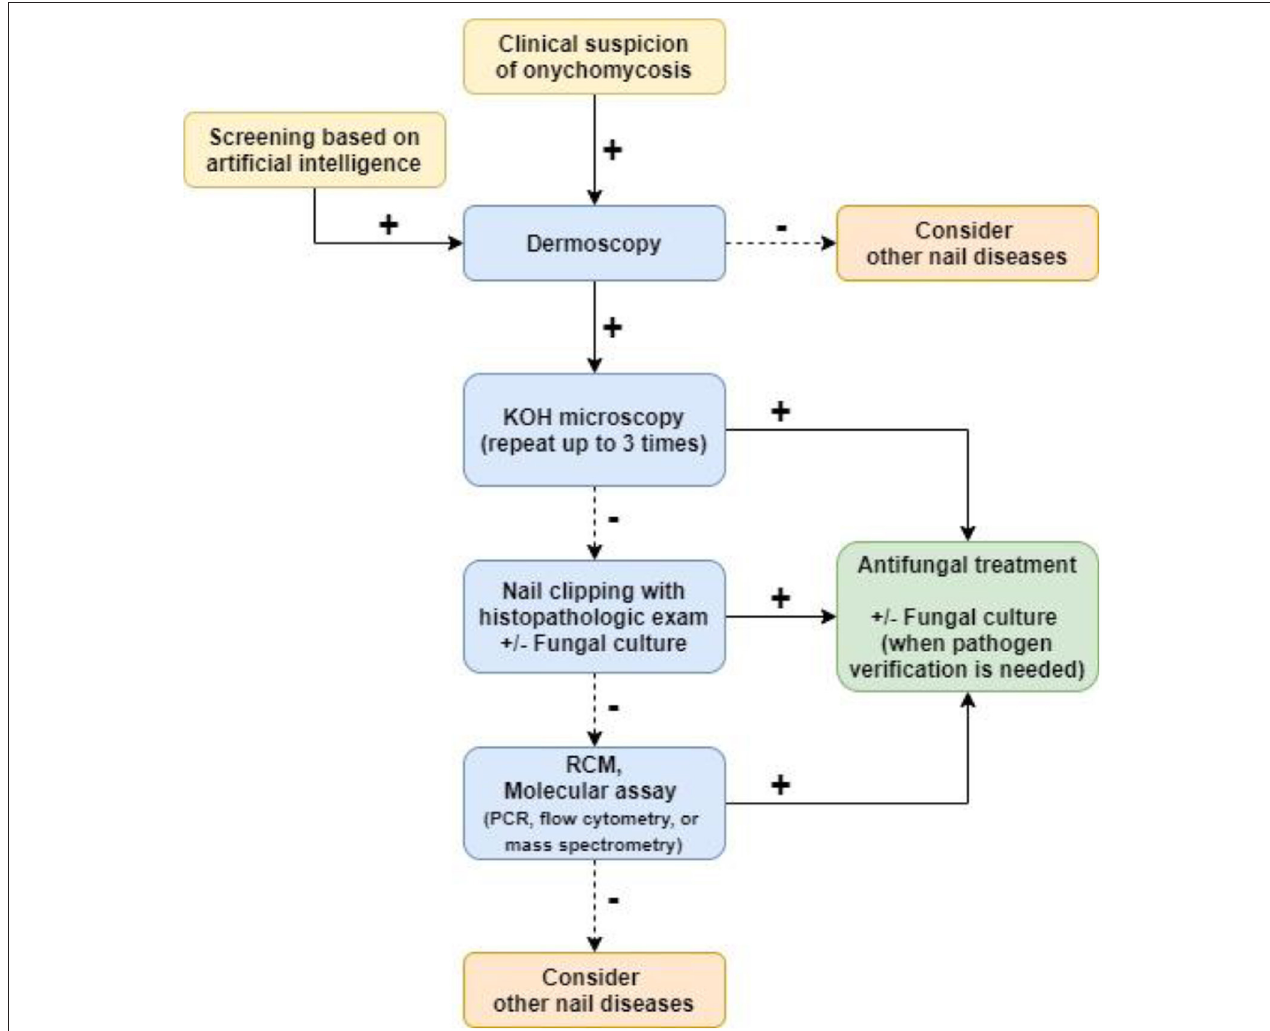
FIGURE 2 | A flowchart for diagnosing